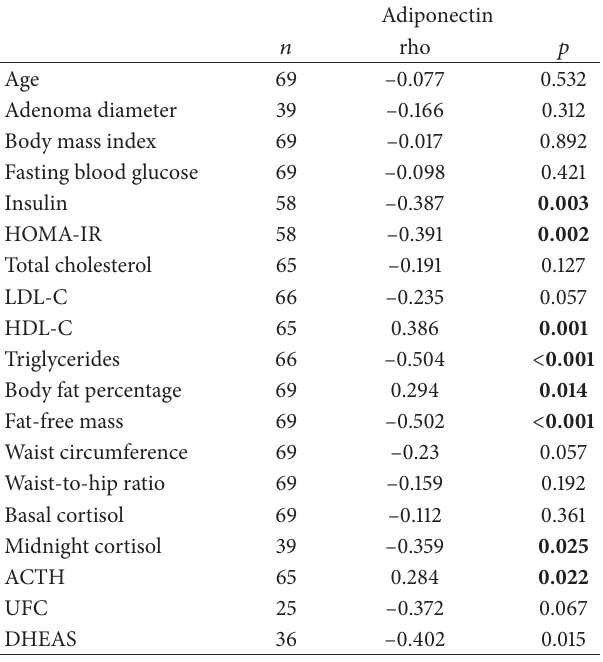
Table 4: Relationship of adiponectin with other parameters.